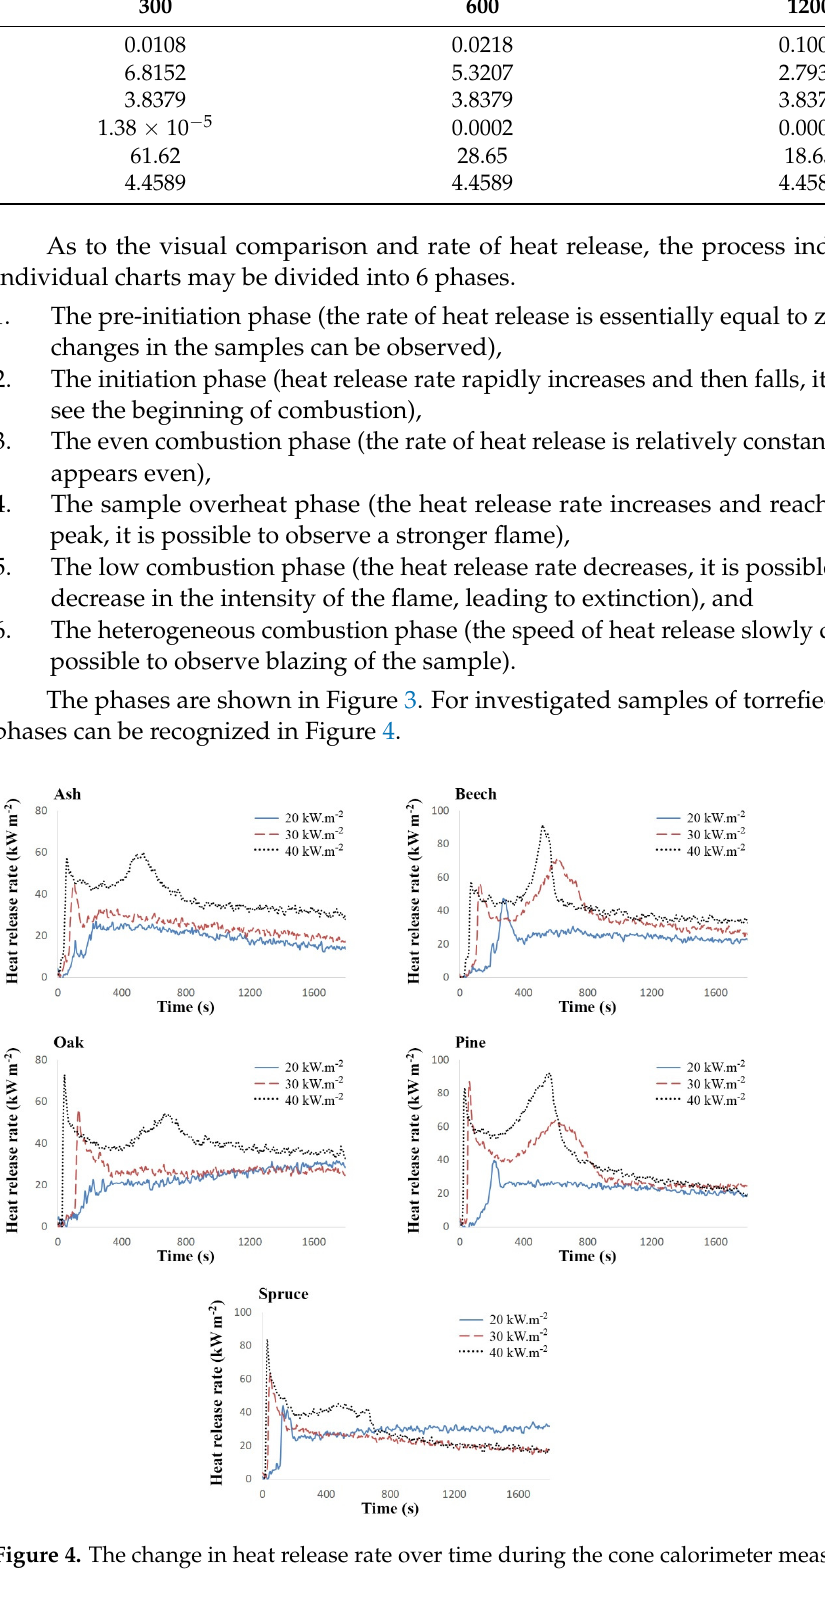
Figure 5. Impact of external heat flux on the time to ignition of torrefied wood.